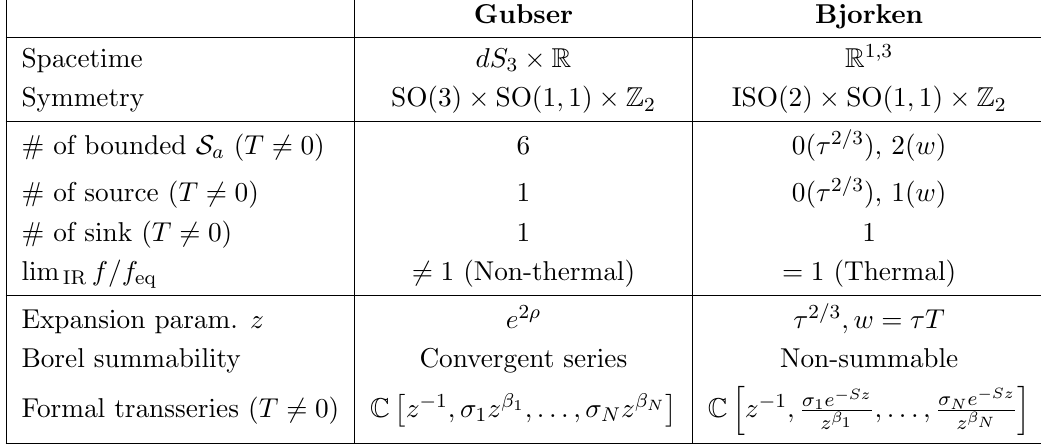
Table 1. Comparison between the Gubser and Bjorken (cid:13)ows. In the (cid:12)rst column from the right, (cid:28) 2 = 3 and w each stand for a separate candidate for the variable z